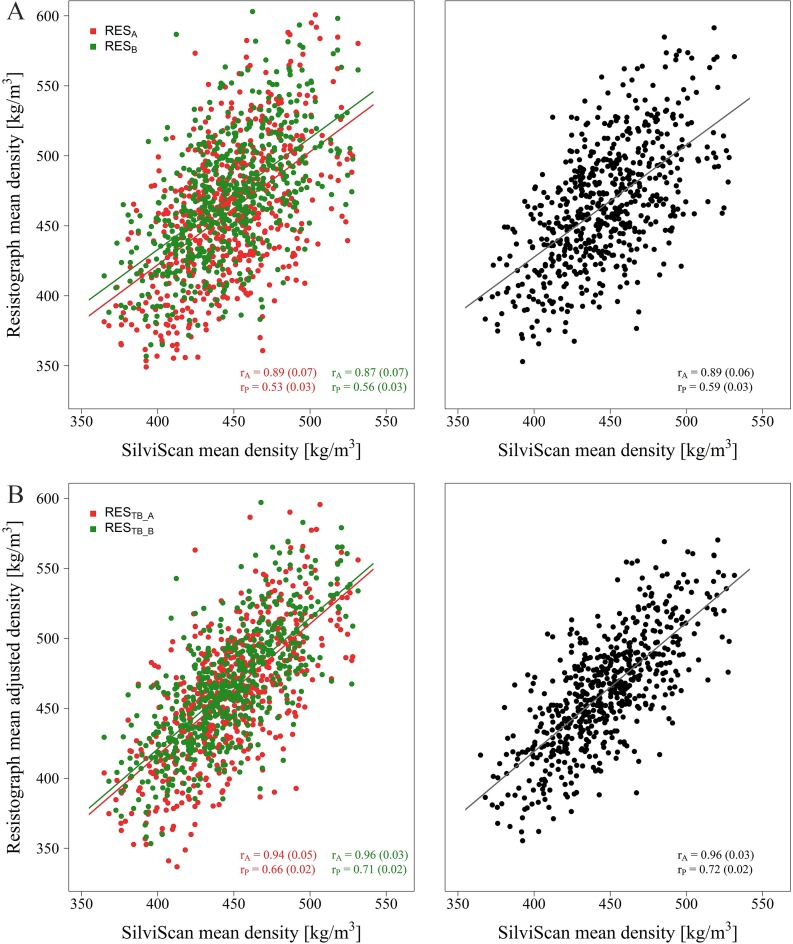
Relationship between SilviScan area-weighted mean density (DEN) and (A) unadjusted Resistograph mean density (RESA and RESB on the left, RES on the right) and (B) adjusted Resistograph mean density (RESTB_A and RESTB_B on the left, RESTB on the right).